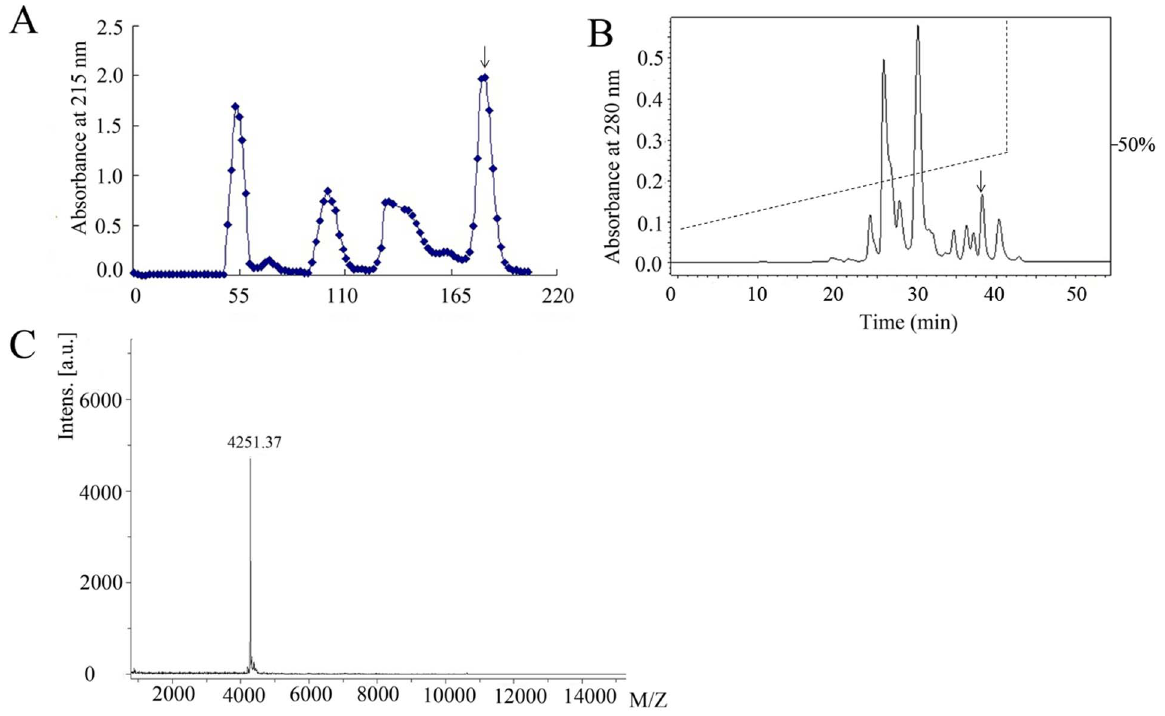
Figure 1. Purification of CFBD from salamander skin secretions of C.fudingensis . (A) Sephadex G-50 gel filtration of C. fudingensis . The elution was performed with 0.1 M phosphate buffer, pH 6.0, each collection of 3.0 ml. (B) Fraction marked by an arrow from the Sephadex G-50 gel filtration was further purified using RP-HPLC. Dashed line indicates linear gradients of acetonitrile. (C) Molecular mass of CFBD detected by mass spectrometry is 4251.37 Da.